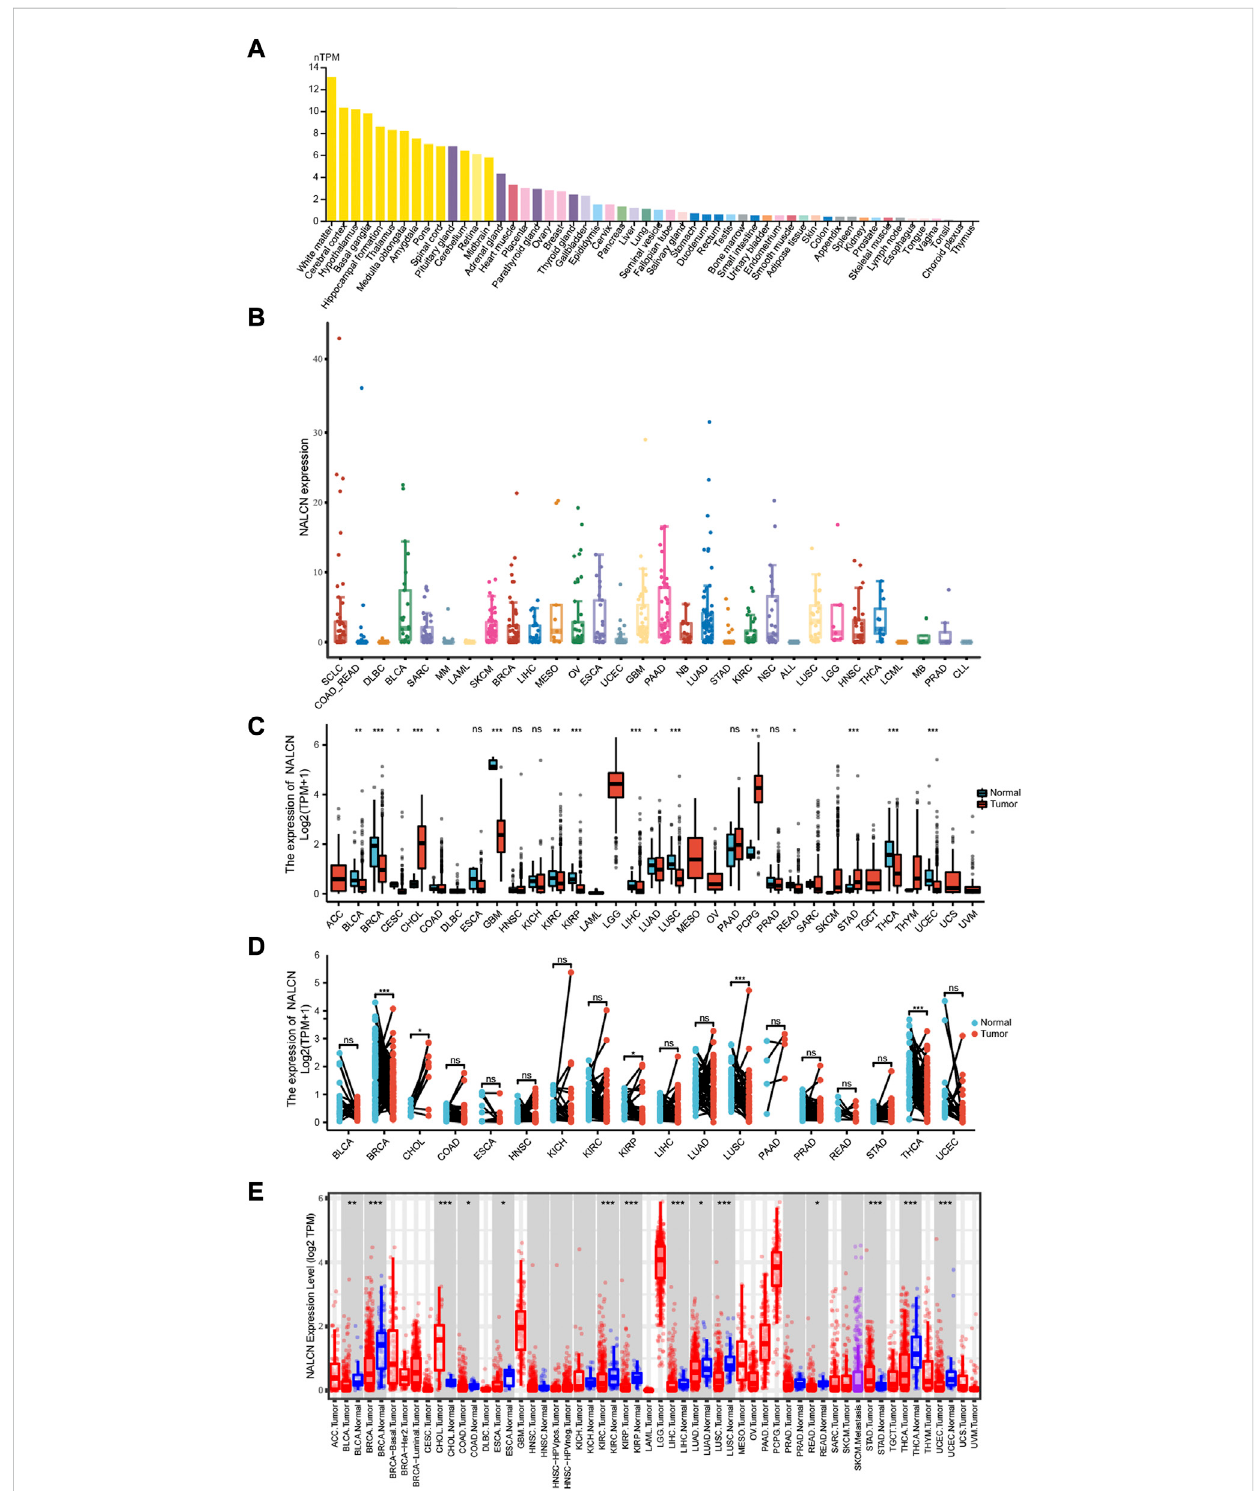
FIGURE 1 DifferentialexpressionofNALCN. (A) ExpressionofNALCNinnormaltissues. (B) ExpressionofNALCNincancercelllines. (C) ComparisonofNALCN between tumor andnormaltissues. (D) Comparison of NALCN between paired tumor and normal tissues. (E) Comparisonof NALCN between tumor and normal tissues in TIMER 2.0. * p < 0.05, ** p < 0.01, *** p < 0.001, ns p ≥